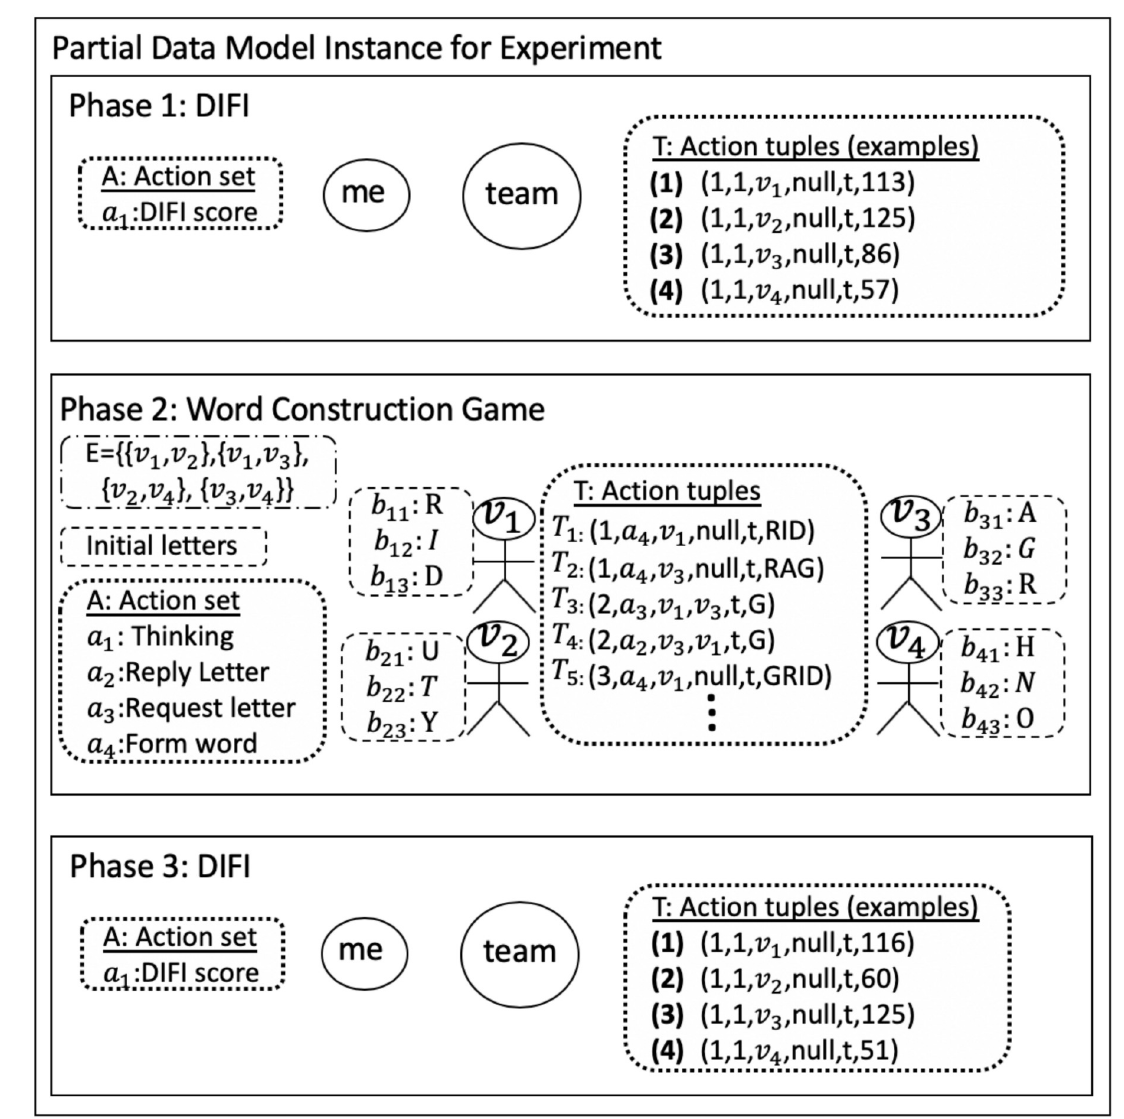
Fig 13. Case study 1. Partial representation of the data model for the online experiment composed of 3 phases with a set of V players ( n = | V |). The phase 1 DIFI measure, a proxy for CI, uses a null (i.e., empty) network on n players; i.e., there are no edges in the graph because players play individually. In phase 2, a team-based CI-priming game, edges E are communication channels. Initial conditions B v include letter assignments to players. The individual DIFI measure is repeated in phase 3. The action set A and illustrative action tuples T i are given for each